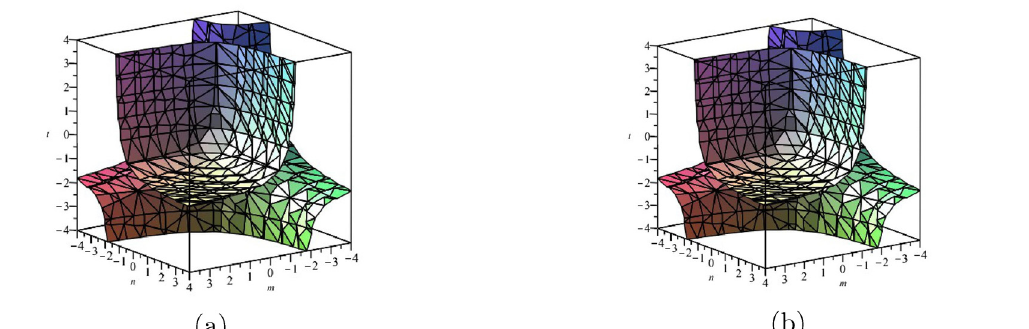
Figure 7: ( a ) The Harmonic index and ( b ) the sum - connectivity